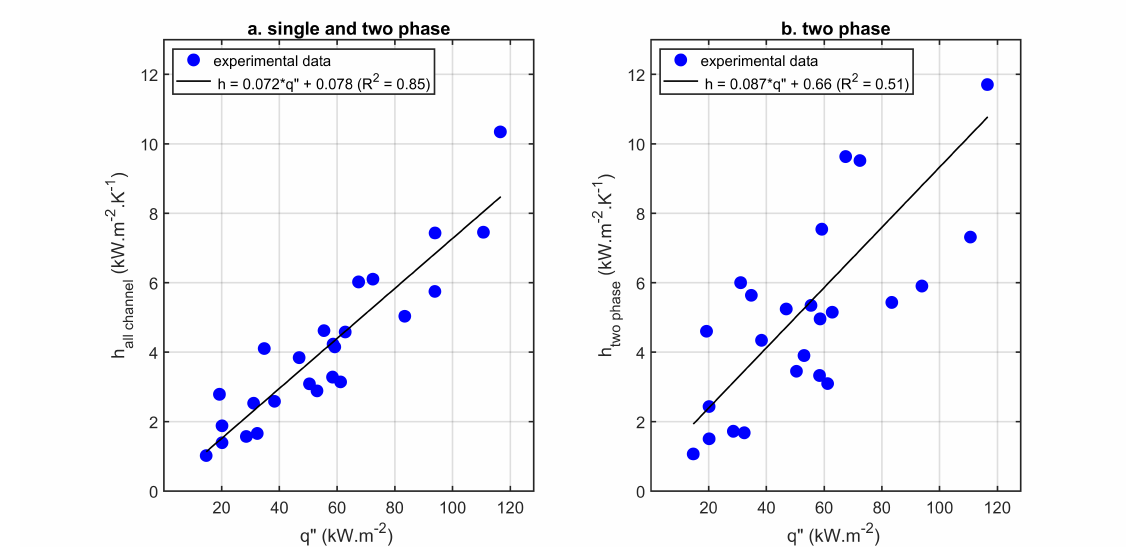
Figure 8. Heat transfer coefficient versus heat flux. ( a ). Mean heat transfer coefficient for both single and two phase regions versus mean heat flux. ( b ). Mean heat transfer coefficient of two phase regions versus mean heat